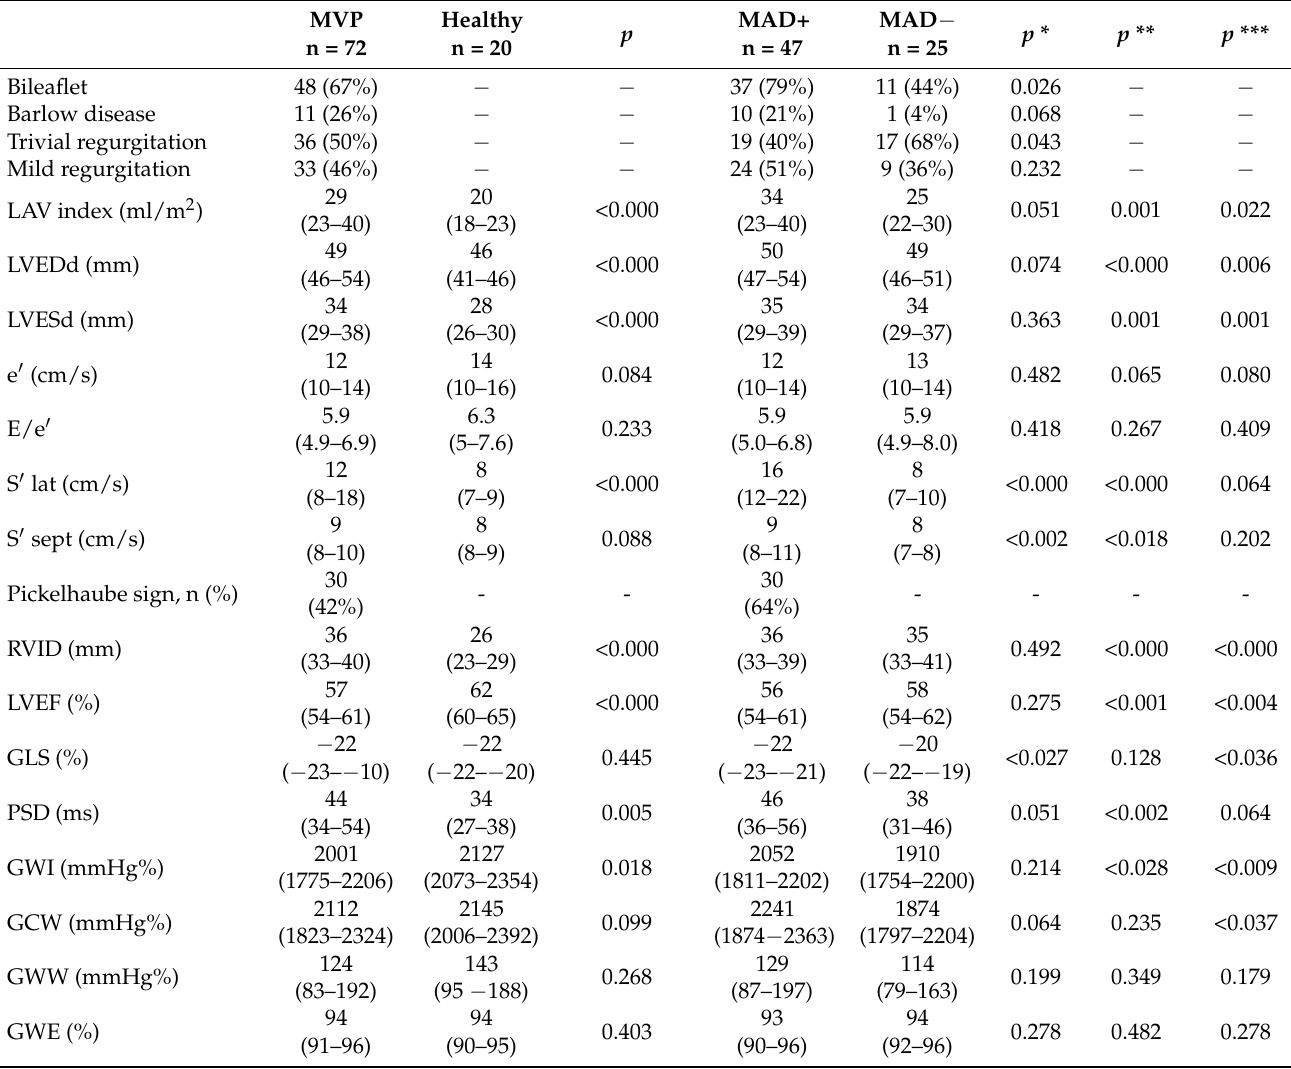
Table 4. Echocardiographic characteristics of MVP